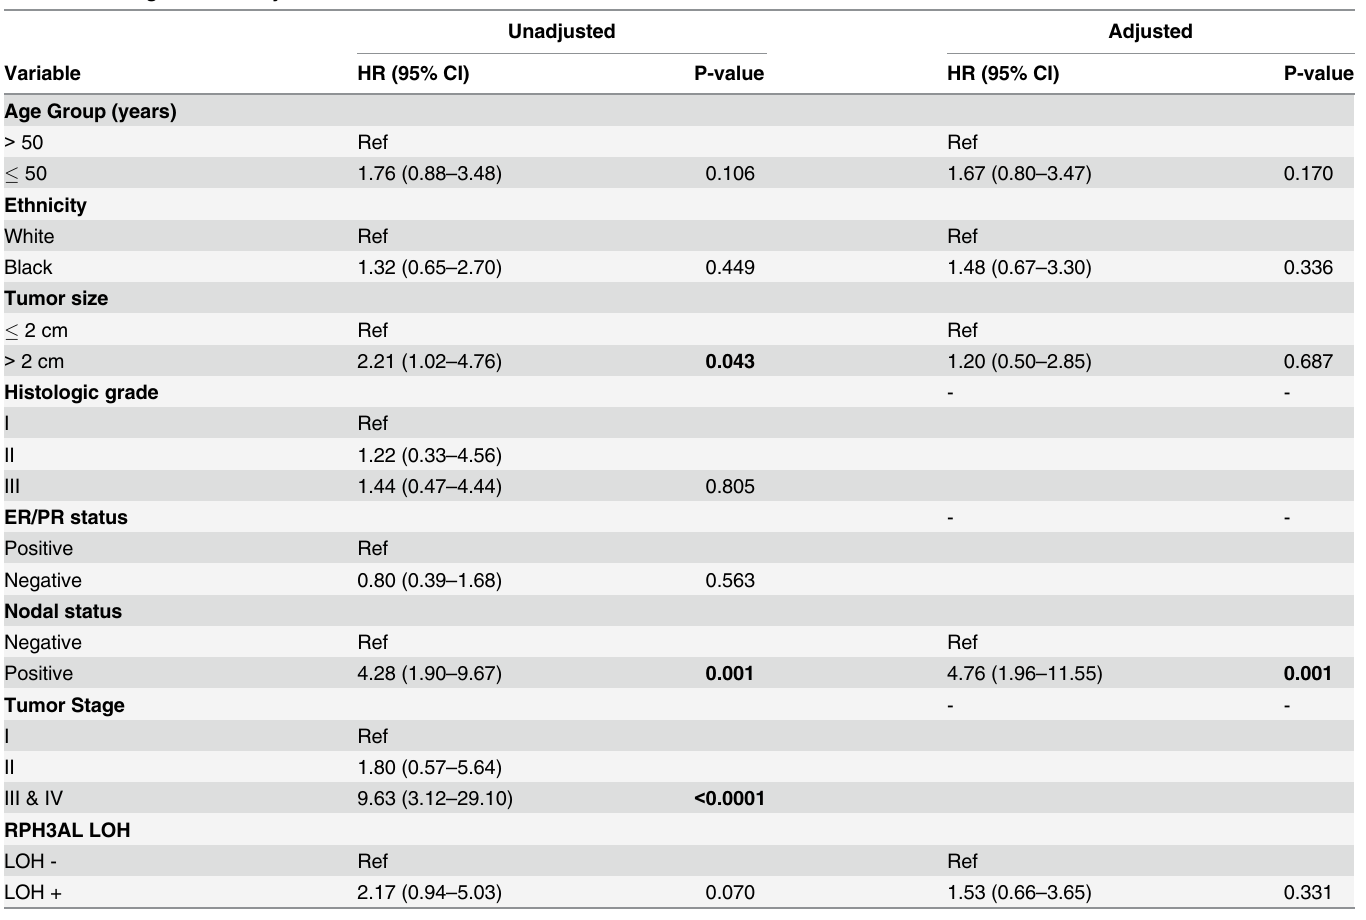
Table 5. Cox regression